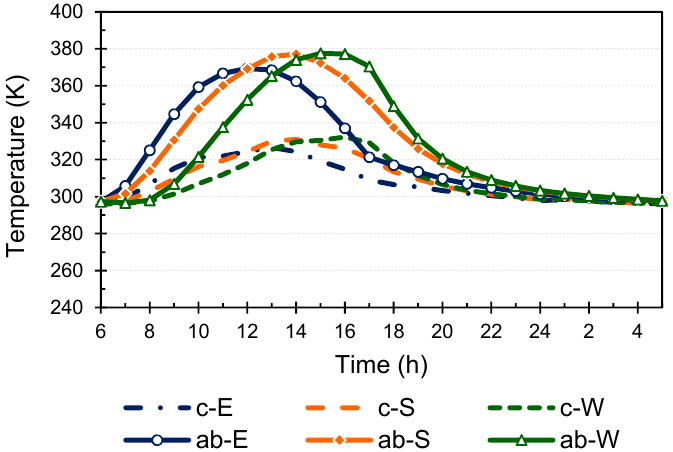
Figure 7. Temperatures of CPCs absorber and cover for each wing (28 August 2005, = L = 1.25 m, and L = 0.5 m). L cpc,E cpc,W cpc,S